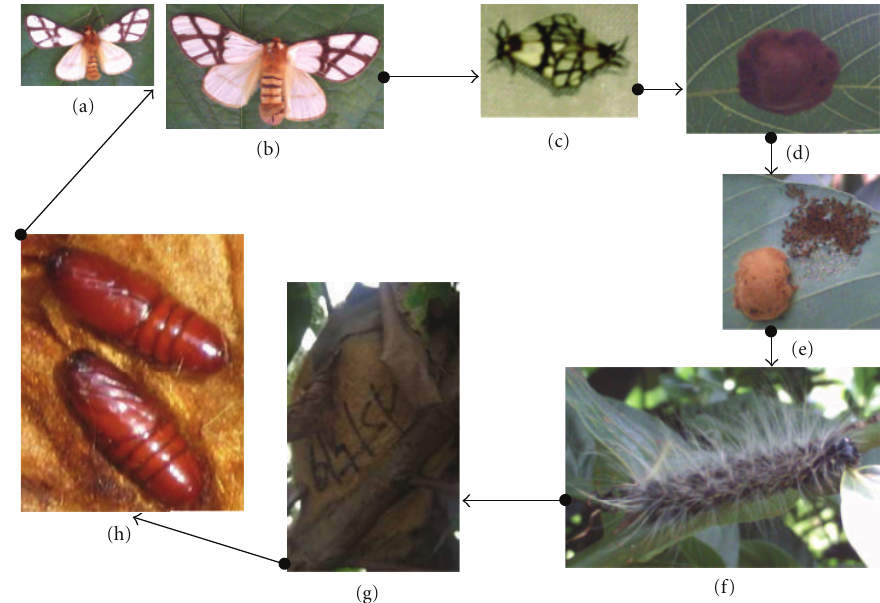
Figure 2: Anaphe panda silkmoth life stages: (a) male; (b) female moths; (c) mating; (d) egg cluster; (e) hatching (1st instar silkworms); (f) 7th instar silkworm on the host plant Bridelia micrantha ; (g) Cocoon nest; (h) Pupae in the cocoon nest.